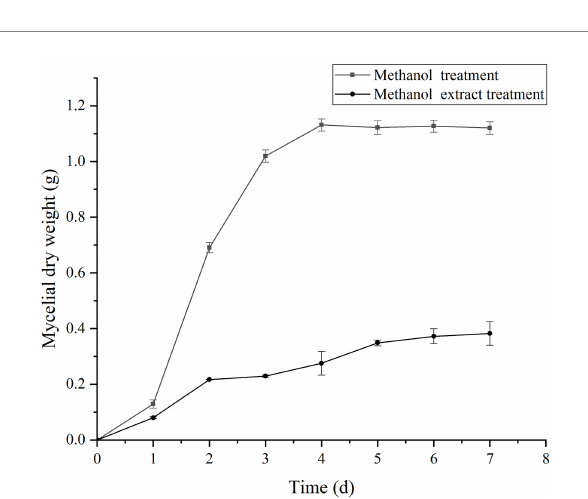
FIGURE 3 Effect of crude methanol extract (100 μ g/ml) on mycelial growth of F. graminearum . The error bars in the figures indicate the standard deviations (±SD) from three independent samples.